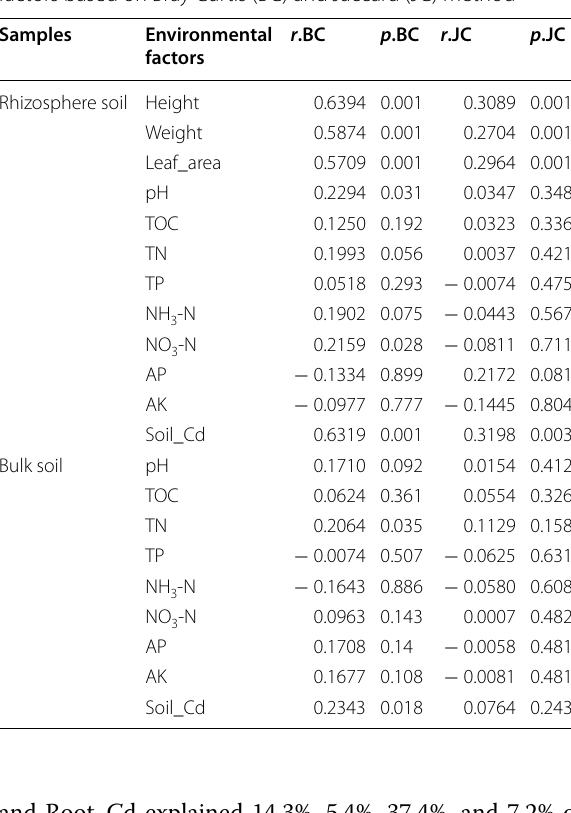
(Additional file 1: Figure S6C) in root endophyte bacterial community, respectively.